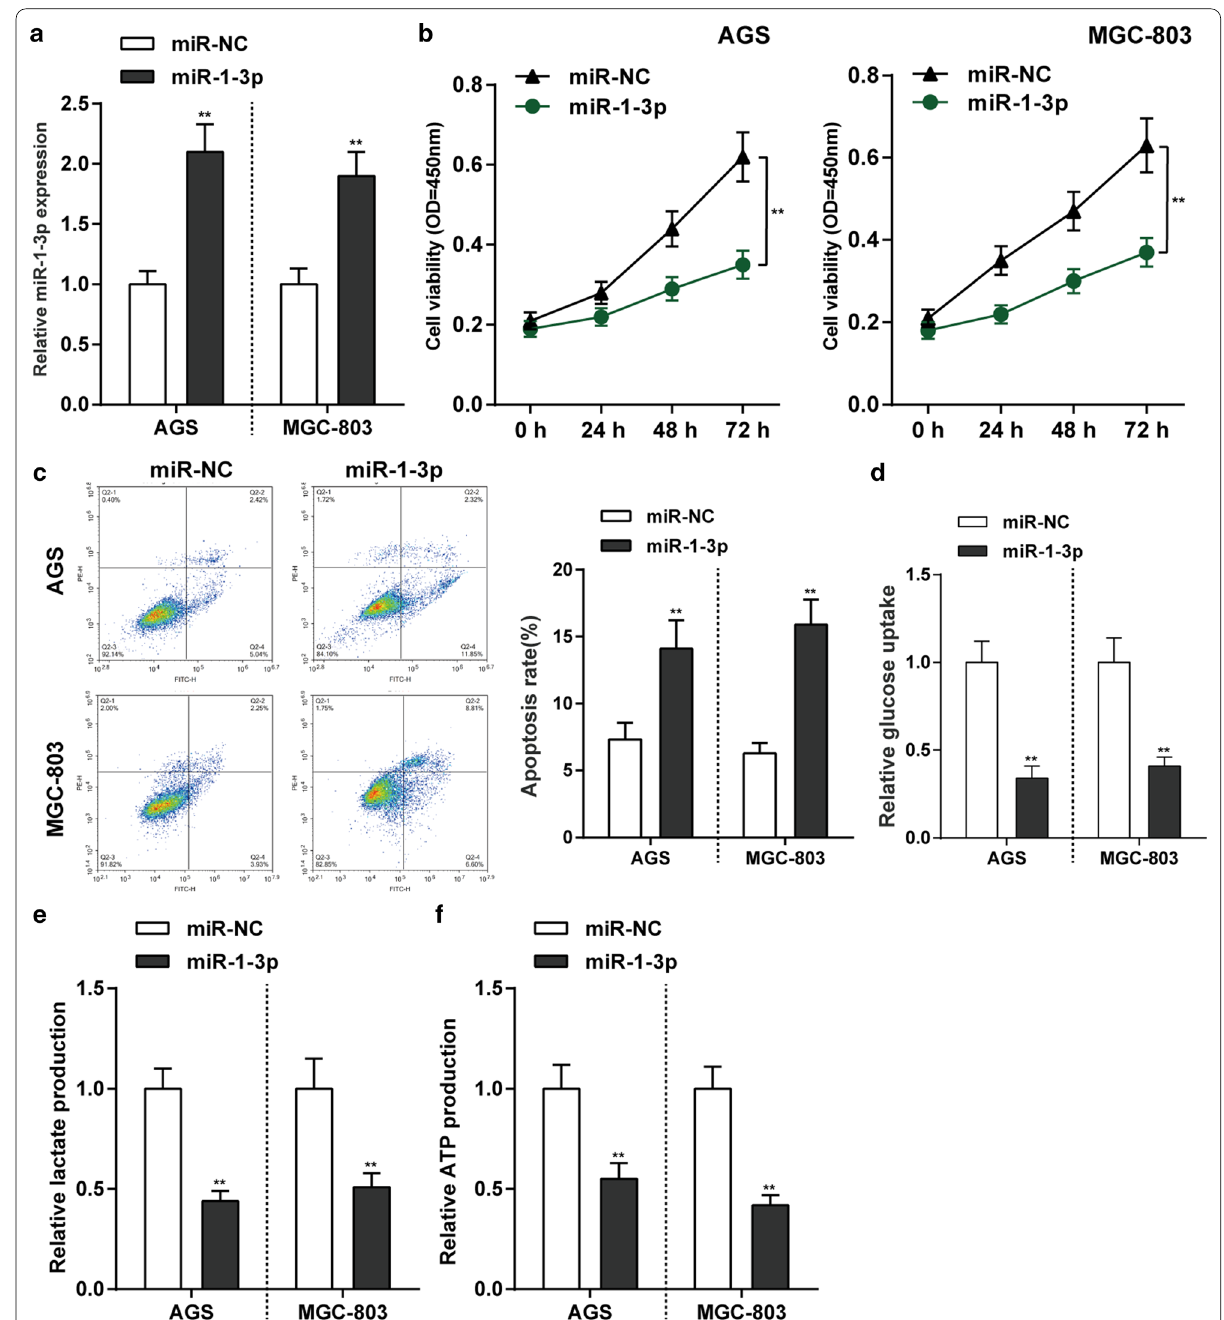
Fig. 5 Effects of miR-1-3p on glycolysis in gastric cancer cells. a miR-1-3p overexpression was conducted in AGS and MGC-803 cells by transfecting miR-1-3p mimics. The transfection efficiency was verified using real-time PCR. b Cell viability was detected by MTT assay. c Cell apoptosis was determined by Flow Cytometry assay. d–f Overexpression of miR-1-3p markedly inhibited glucose consumption ( d ), lactate production ( e ) and ATP production ( f ) in both AGS and MGC-803 cells. N 3; ** P < 0.01 compared to miR-NC =